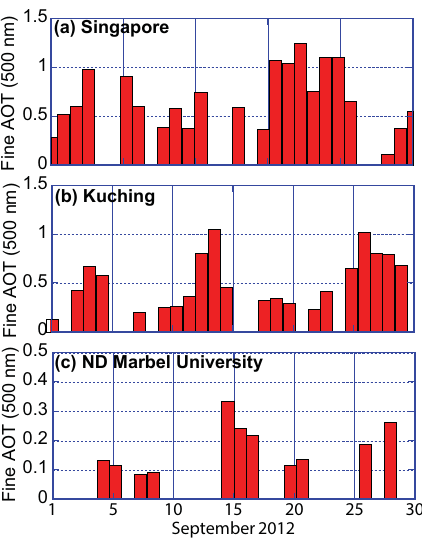
Figure 3. AERONET 500nm fine-mode aerosol optical thickness for three sites surrounding the study